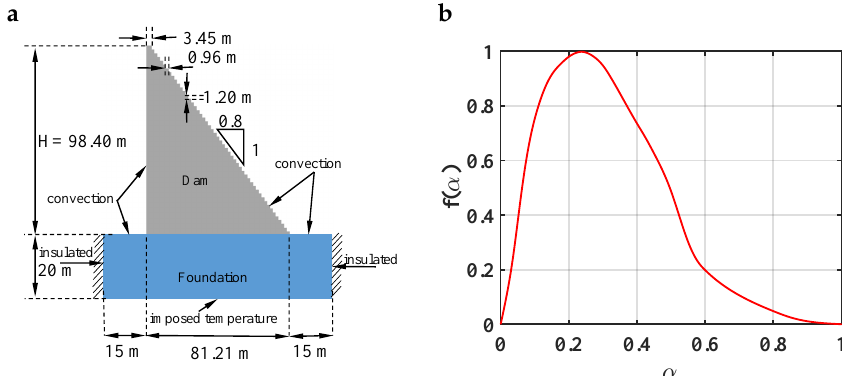
Figure 1. Illustration of the case study and properties of the concrete. ( a ) We simulate the thermal evolution of a roller-compacted concrete (RCC) dam during the construction phase. The boundaries of our numerical model are: (1) convection at the surfaces in contact with the air at the corresponding equivalent temperature, (2) no heat flow at the vertical boundaries of the foundation, and (3) imposed temperature at the bottom of the foundation. In the same figure, we also include the dimensions of our model. ( b ) Here we plot the normalized heat generation function, f ( α ) , against the degree of hydration, α , of